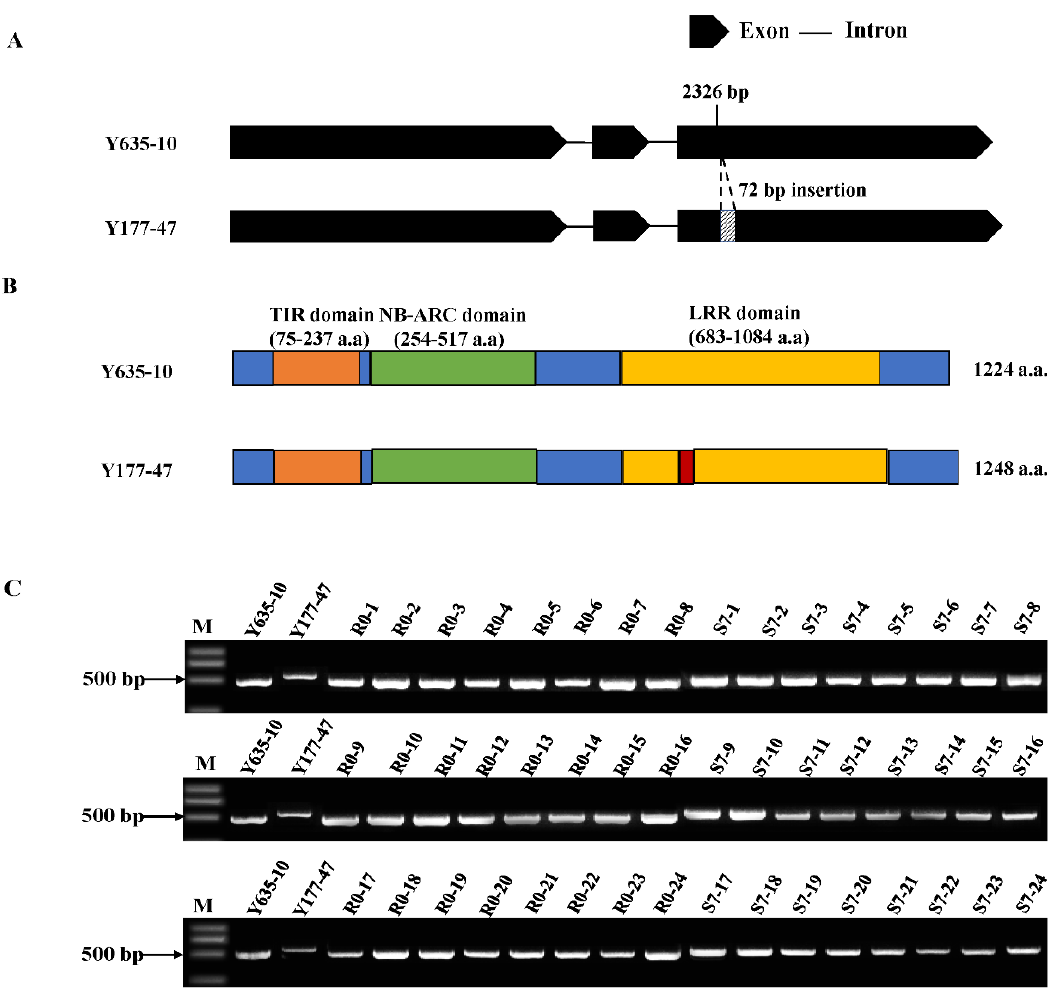
Figure 5. CRq gene structure, amino acid analysis and protein structure prediction. ( A ) CRq con- tains 3 exons and 2 introns. Base insertions numbering 72 occurred in 2326 bp of the third exon of susceptible plants. ( B ) Protein structure of the missing part in the two parents, and the insertion